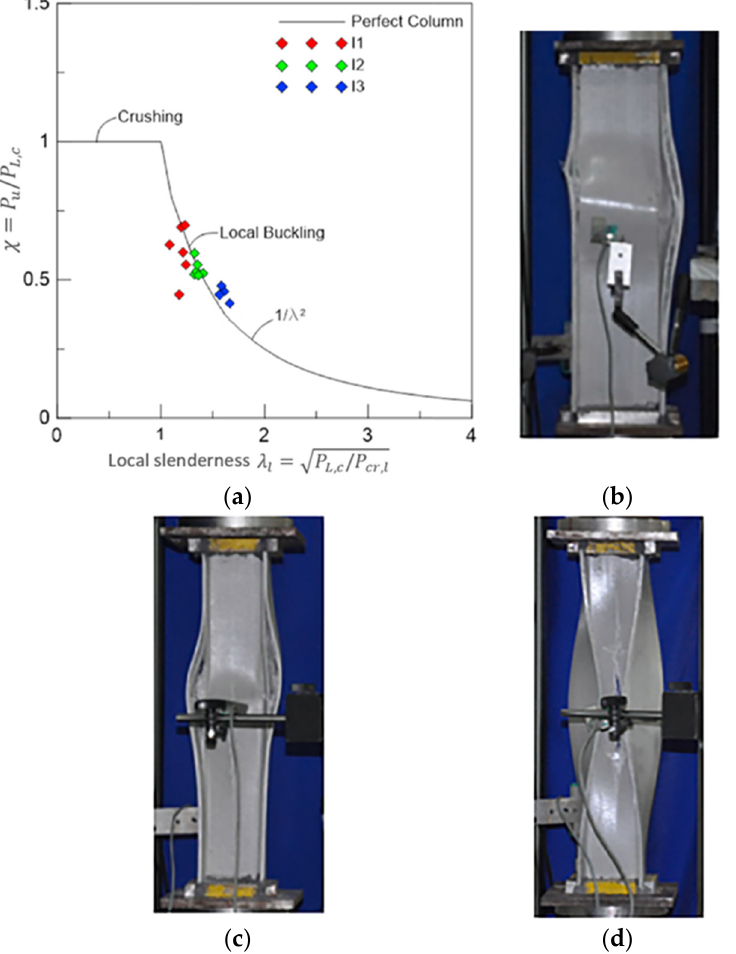
Figure 12. Interaction between local buckling and compressive failure of I-shape PFRP columns with different cross-sectional aspect ratios: ( a ) strength curve with experimental points (P u : the ultimate compressive load, P L,C : the experimental buckling load, and P cr,l : the critical buckling load); ( b ) experimental failure mode of I 1 (b f /d = 0.5); ( c ) experimental failure mode of I 2 (b f /d = 0.75); and ( d ) experimental failure mode of I 3 (b f /d = 1.0) [69].